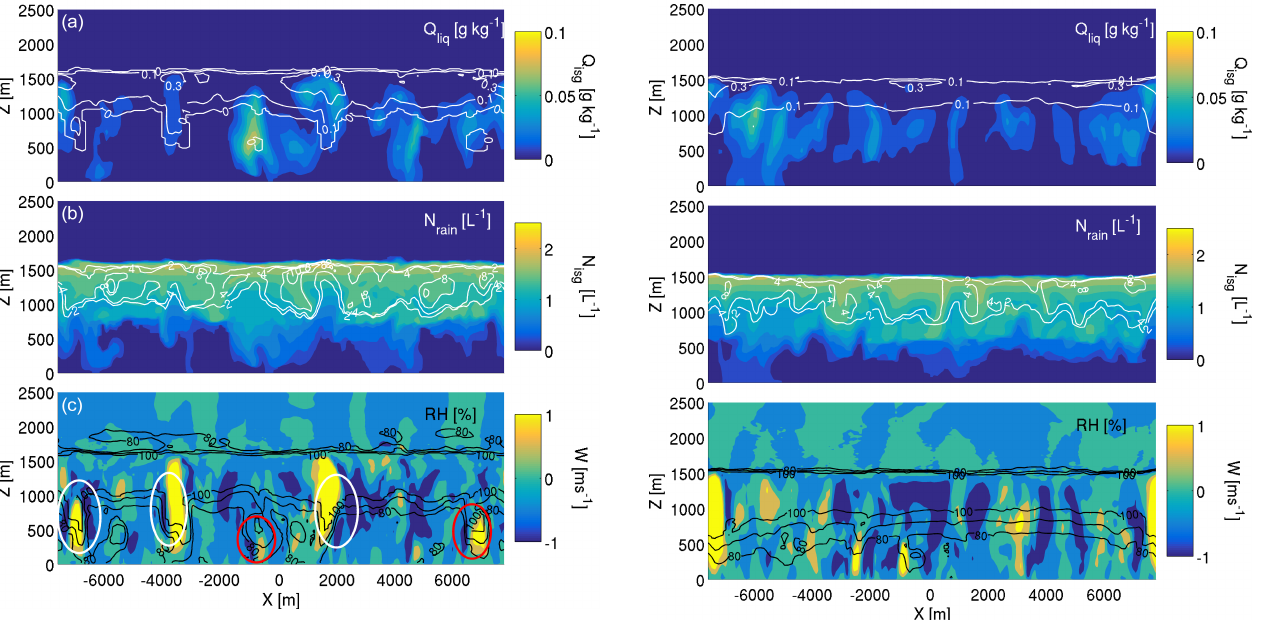
Figure 12. Z – X slices for the HISUB_SURFWARM case at 12h. Panels are arranged similarly to Fig.